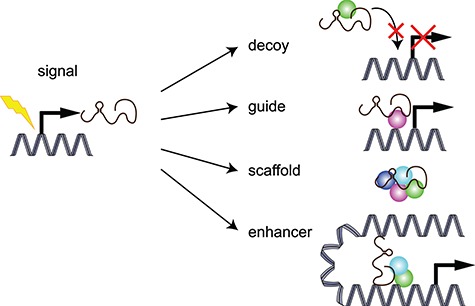
Classification of lncRNAs according to their molecular mechanism of action.